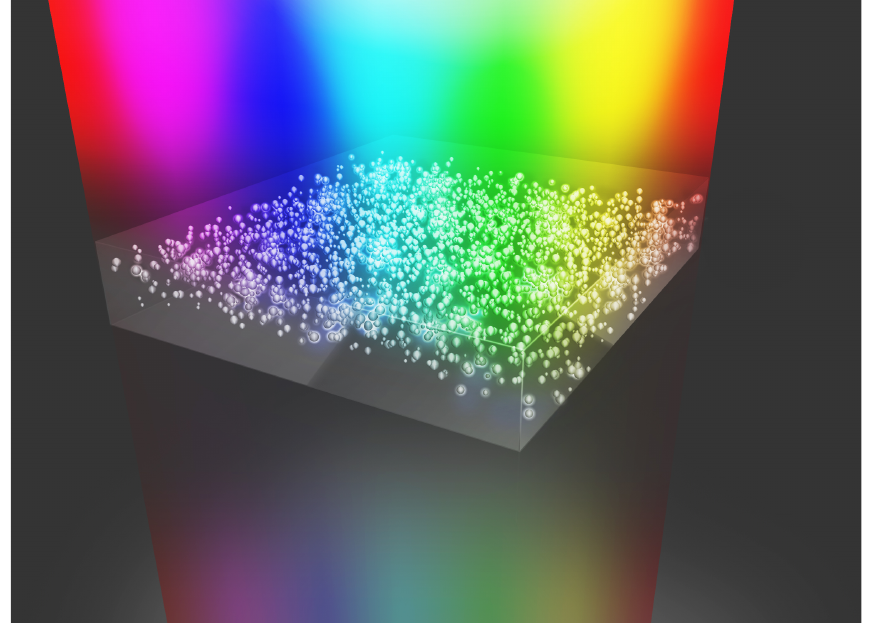
Figure 1. Schematic of the configuration under consideration. A plasmonic nanocomposite made from densely, but randomly, arranged metallic nanoparticles shall be an integrated part of an optical device, e.g., as an anti-reflection coating. The consideration of the entire material in an optical analysis of such a device is too complicated. Therefore, it should be described by effective optical properties to predict the reflected and transmitted light properly; as indicated in the